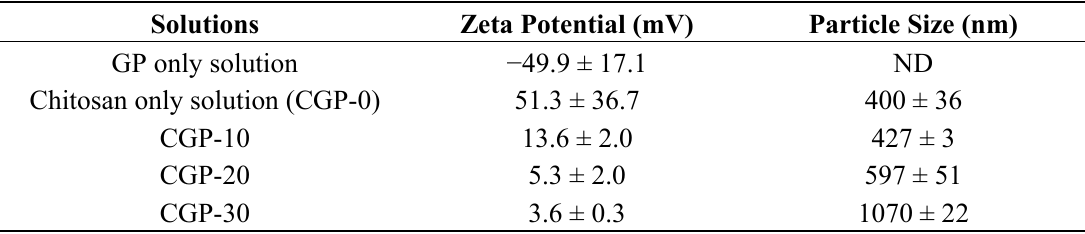
Table 1. Zeta potentials and particle sizes of GP only solution, chitosan only solution, CGP-10, CGP-20 and CGP-30 at 37